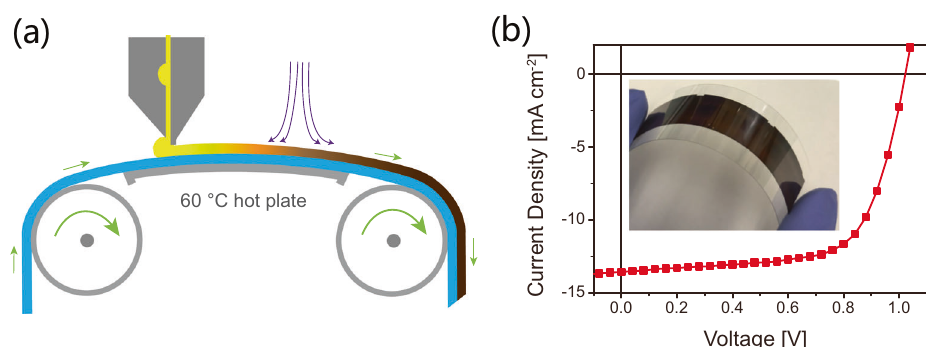
Fig. 7 R2R slot-die coating and device performance for the 2D perovskite fi lm. a R2R slot-die coating of a 2D perovskite fi lm; b the J – V curve for a champion perovskite solar cell and photograph of the iso-BA-2D perovskite fi lm prepared using the R2R process